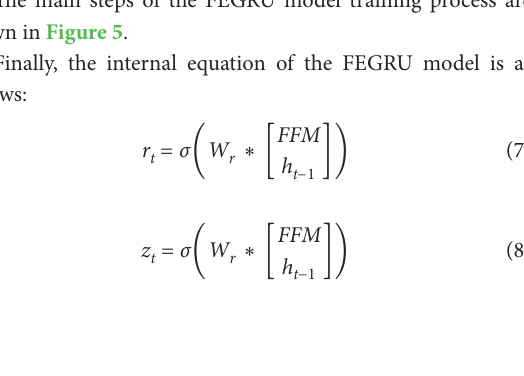
function. 6. loss calculation is performed at each epoch and back propagation is performed to update the